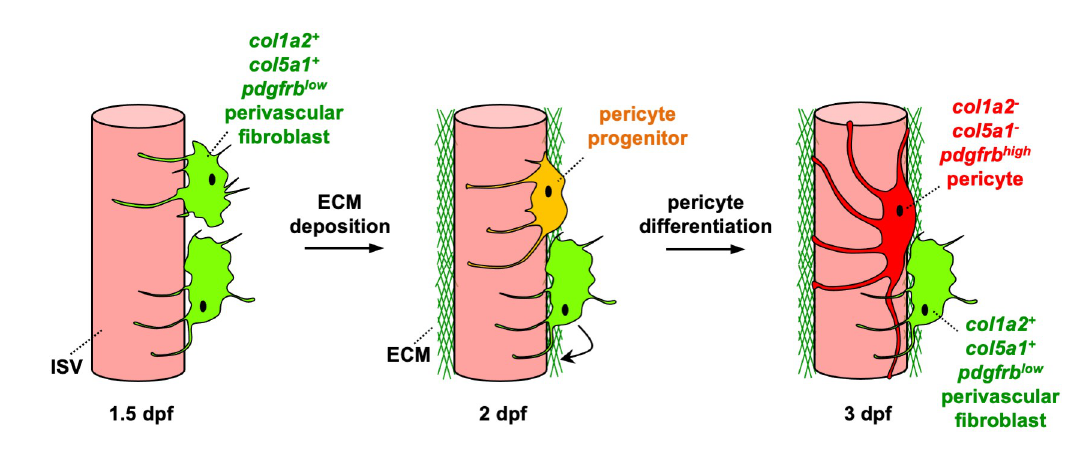
Fig 7. Model of perivascular fibroblasts in vascular stabilization in zebrafish. Perivascular fibroblasts, characterized by the expression of fibrillar collagens col1a2 and col5a1 as well as low levels of pdgfrb , become associated with intersegmental vessels (ISVs) in the zebrafish trunk by 1.5 dpf. Perivascular fibroblasts deposit a network of collagen fibers to establish the vascular ECM and stabilize nascent ISVs at 2 dpf and continue to deposit collagen until at least 3 dpf. In the same time window, a subset of perivascular fibroblasts functions as pericyte progenitors. They gradually upregulate the expression of the classic pericyte marker pdgfrb and develop elongated cellular processes. By 3 dpf, these ‘pericyte progenitors’ have completely differentiated into mature pericytes, showing robust pdgfrb expression distinct from collagen-expressing perivascular fibroblasts. Together, perivascular fibroblasts perform dual functions in vascular stabilization by depositing collagens to support nascent blood vessels and acting as pericyte progenitors.